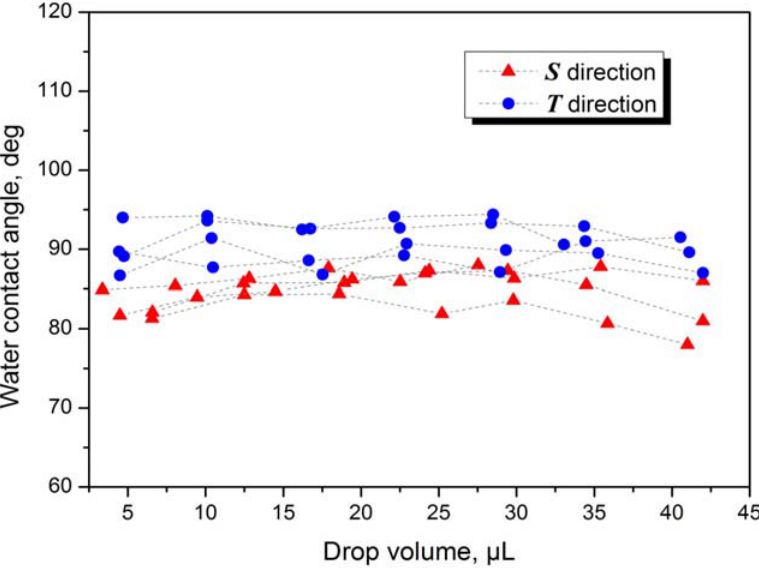
Figure 2. Gravitational effect of drop volume on contact angles for Sample